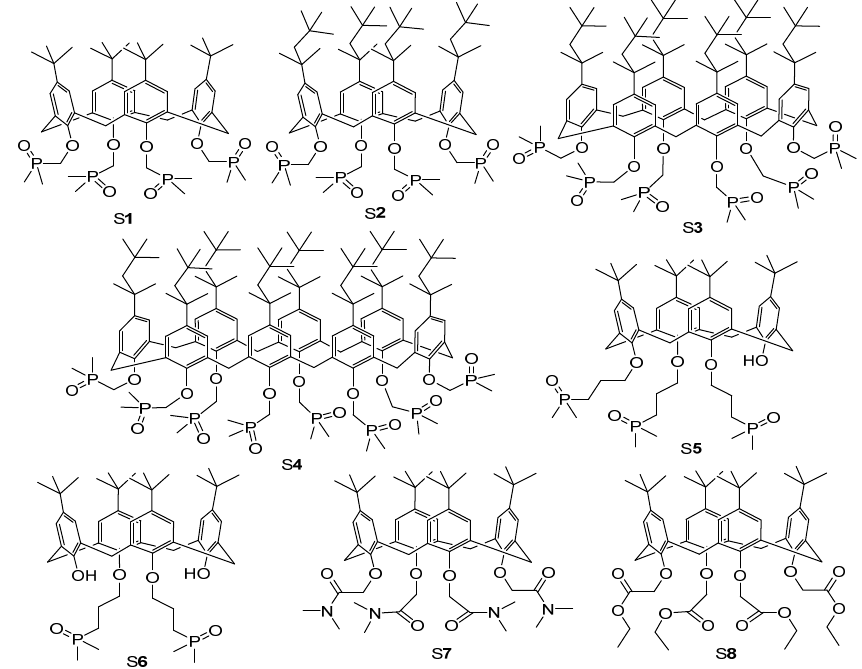
Figure 6. Chemical structures of several selected calixarenes.